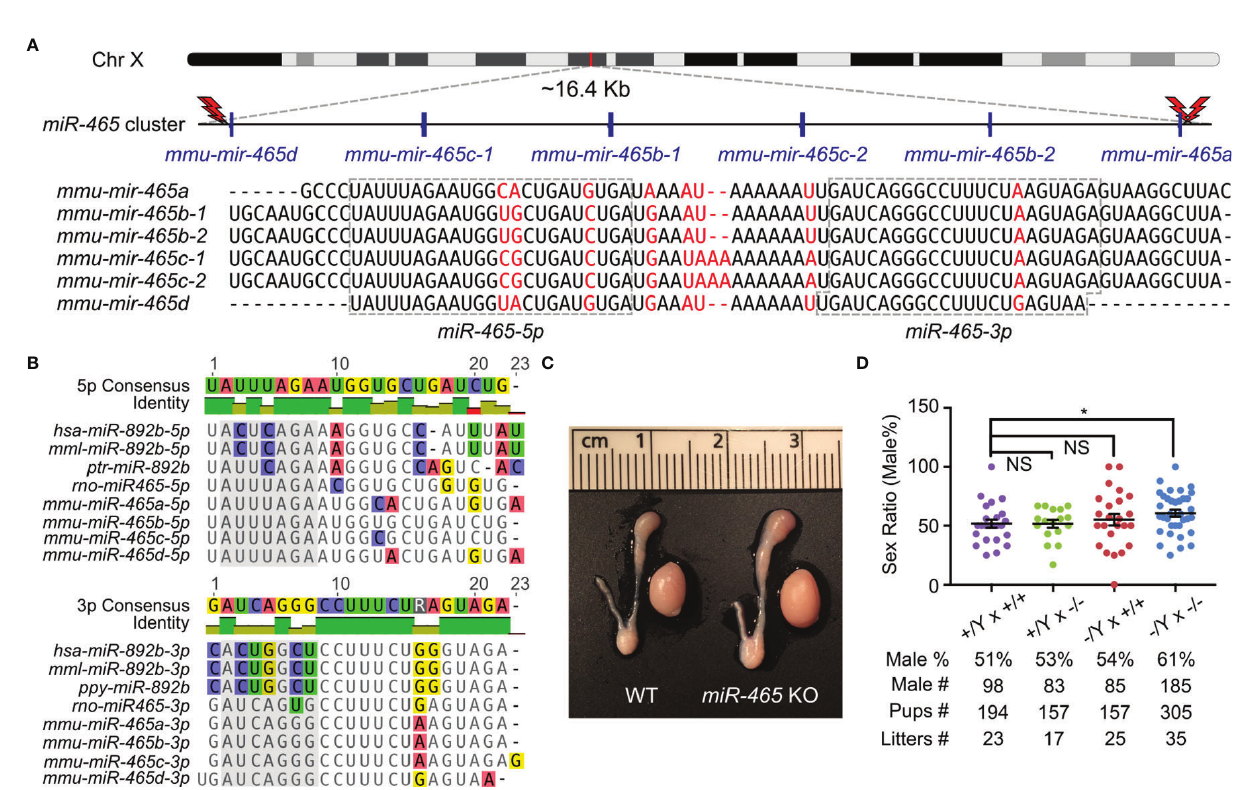
FIGURE 1 | Generation of miR-465 KO mice. (A) The genomic location and sequences of the miR-465 cluster on the X chromosome of mice. The red lightning bolts represent the gRNAs used, and their right and left orientations indicate the reverse and forward strands targeted by the gRNAs, respectively. (B) The orthologs of the miR-465 cluster in primates and rodents. Bases highlighted in the grey background are the potential seed regions. (C) A representative image of the testis and epididymis of WT and miR-465 cluster KO mice. One unit on the ruler is 1 mm. (D) The sex ratios among pups from different breeding schemes. *, p<0.05; NS, statistically not signi fi